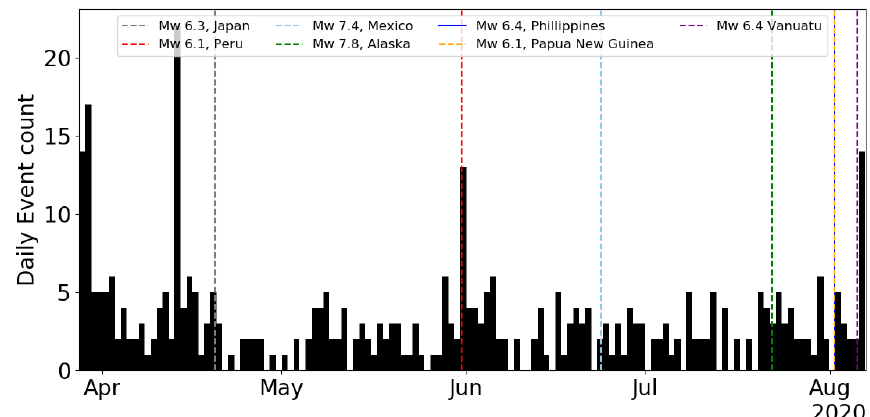
Figure 7. Teleseismic events (dotted vertical lines) that statistically (95% confidence level) generated dynamic triggering of seismicity within the KSMMA during a period of quiescence from April to August 2020. Daily event counts are shown as black bars. Statistical analysis ( β statistic following Matthews and Reasenberg, 1988) performed in the 12h prior to the teleseismic event and 12h